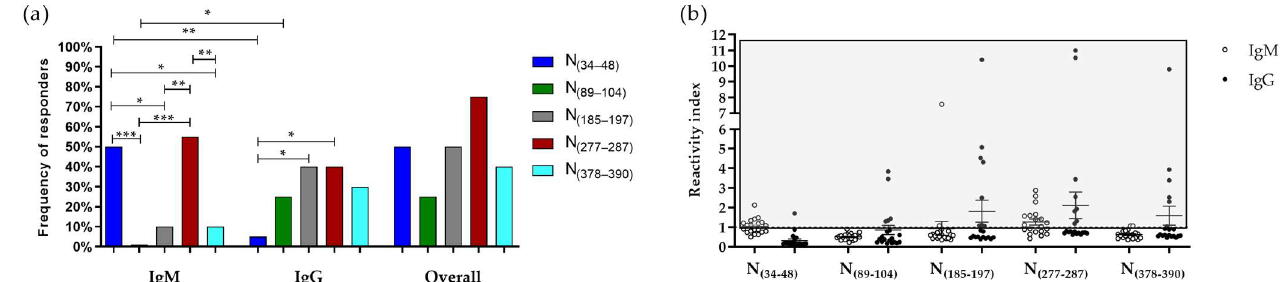
Figure 3. Evaluation of natural immunogenicity of predicted epitopes. ( a ) Frequencies of IgM, IgG, and overall responders to N (34–48) (blue bar), N (89–104) (green bar), N (185–197) (gray bar), N (277–287) (red bar), and N (378–390) (light blue bar). The frequencies of responders to epitopes were compared by Fisher’s exact test, and statistical differences were indicated by asterisks: (*) = p < 0.05; (**) = p < 0.01; (***) = p < 0.001. ( b ) IgM (white dots) and IgG (black dots) reactivity indexes against predicted epitopes. Responders to peptides were indicated above the traced line.